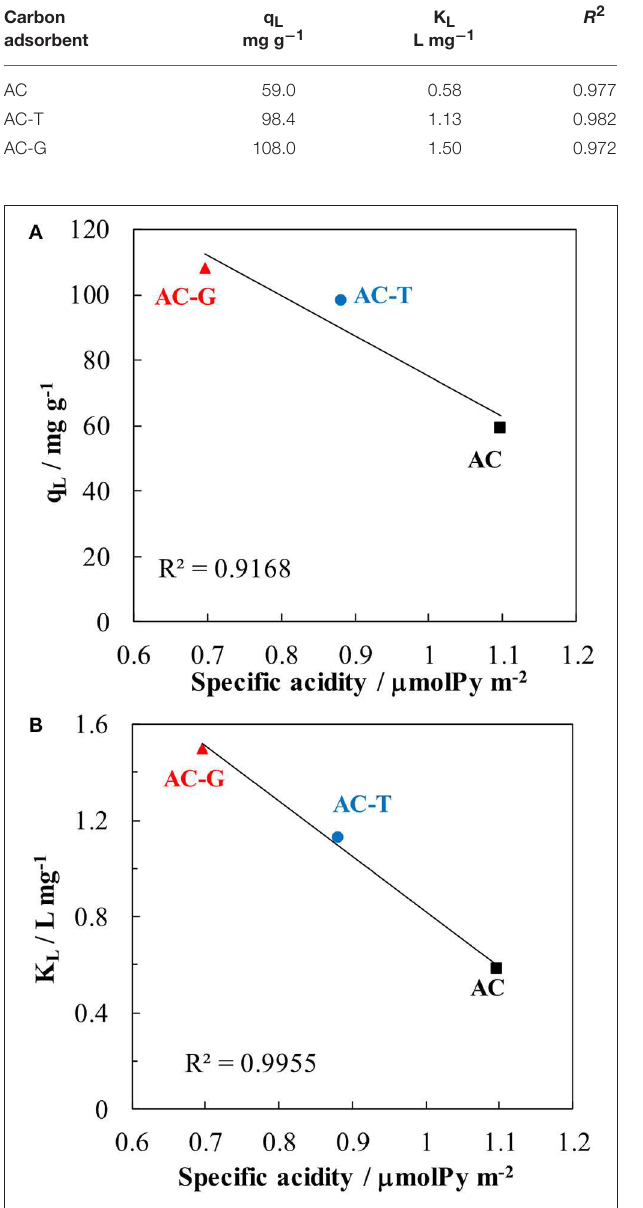
FIGURE 7 | Relationship between paracetamol adsorption capacity and specific acidity (A) and paracetamol adsorption equilibrium constant and specific acidity (B) .